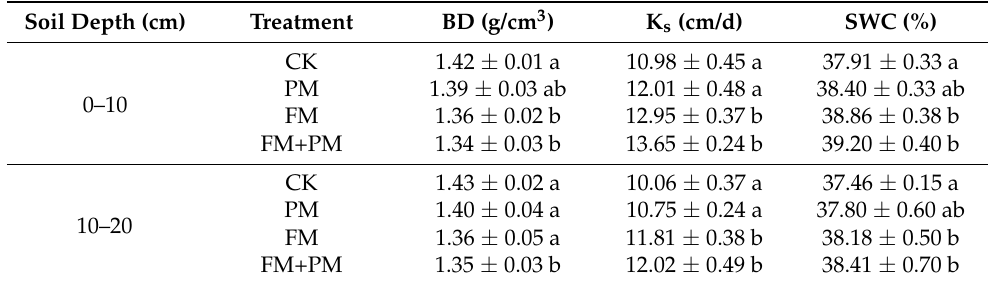
Table 2. Soil physical properties under different